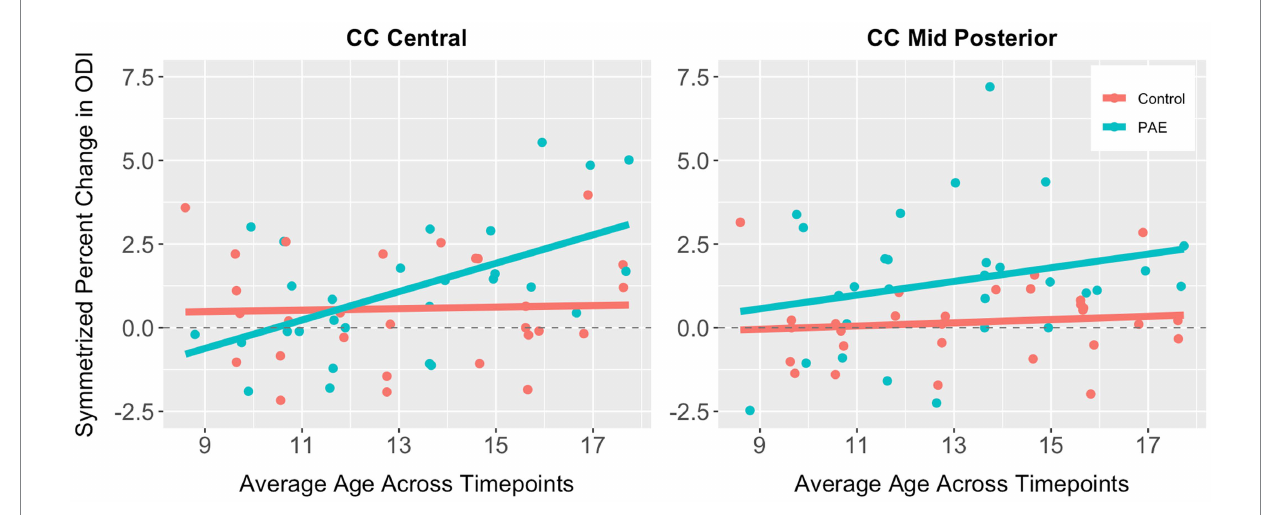
FIGURE 3 Scatterplots illustrating group differences in symmetrized percent change in ODI in the central and mid posterior corpus callosum. Results are displayed for general linear models examining group differences (PAE vs. Control) in developmental timing and degree of change in corpus callosum white matter microstructure.